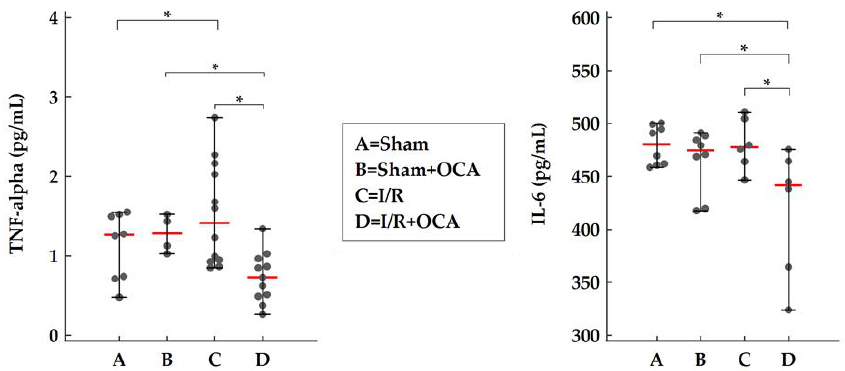
Figure 4. OCA treatment decreases cortex TNF-alpha and IL-6 in rats submitted to partial liver ischemia (60 min) followed by reperfusion (120 min). Animals were orally administered with OCA 10 mg/kg/day in methylcellulose 1% for 5 days ( n = 12) or with vehicle alone ( n = 12). Sham-operated animals were subjected to the same procedure without clamping the vessels. n = 6 rats/group. Results are expressed as median value (red line) ± error bar (1–99 percentiles) (black dot). Kruskal–Wallis test with Conover test. * p < 0.05 versus I/R rats.